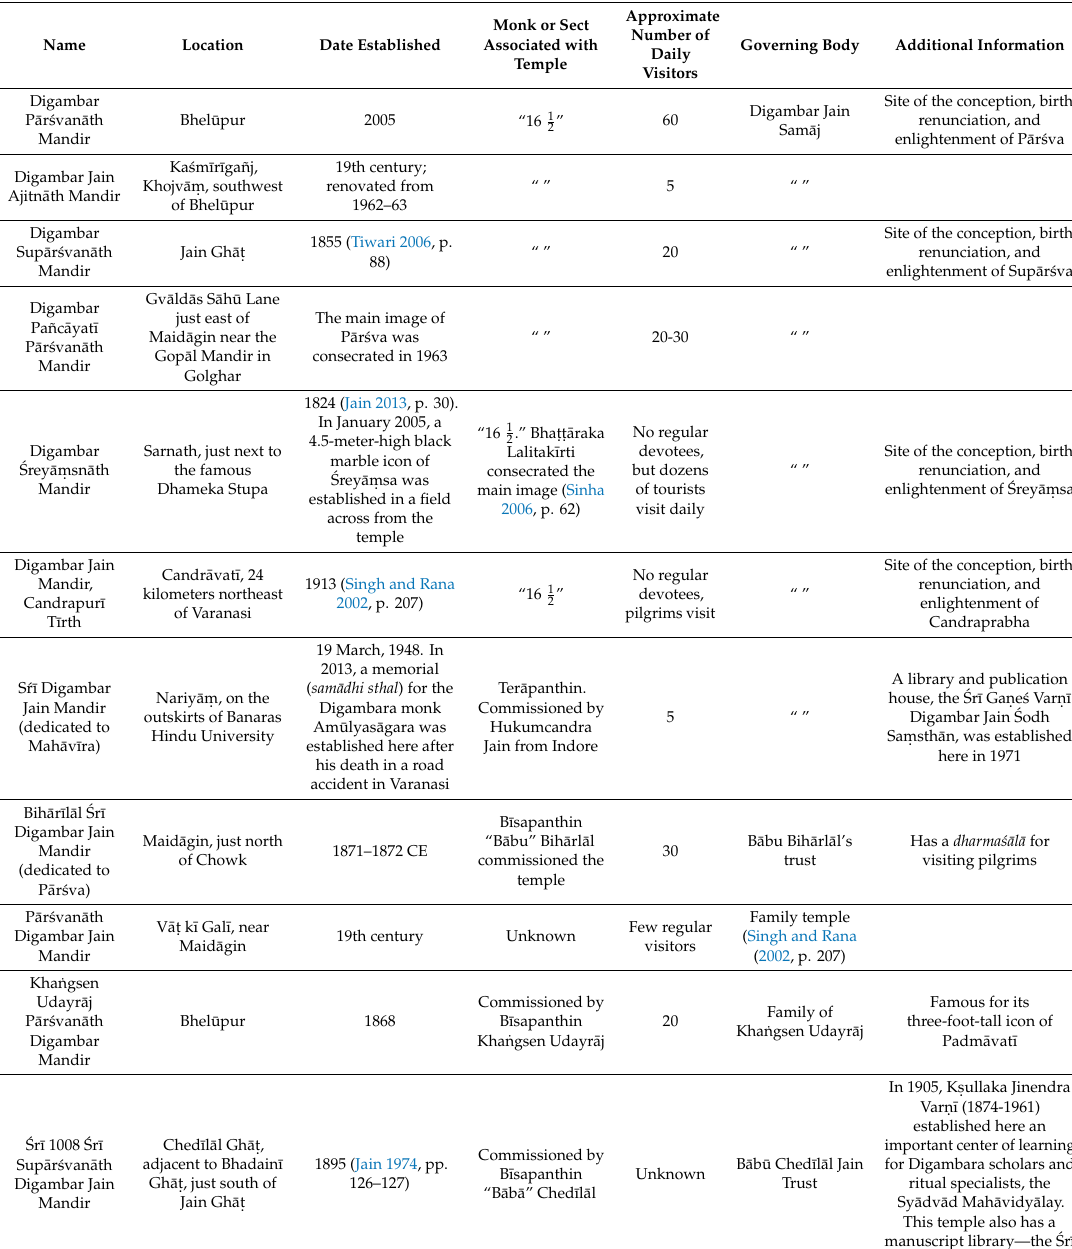
Table 4. Digambara temples in Varanasi. 23